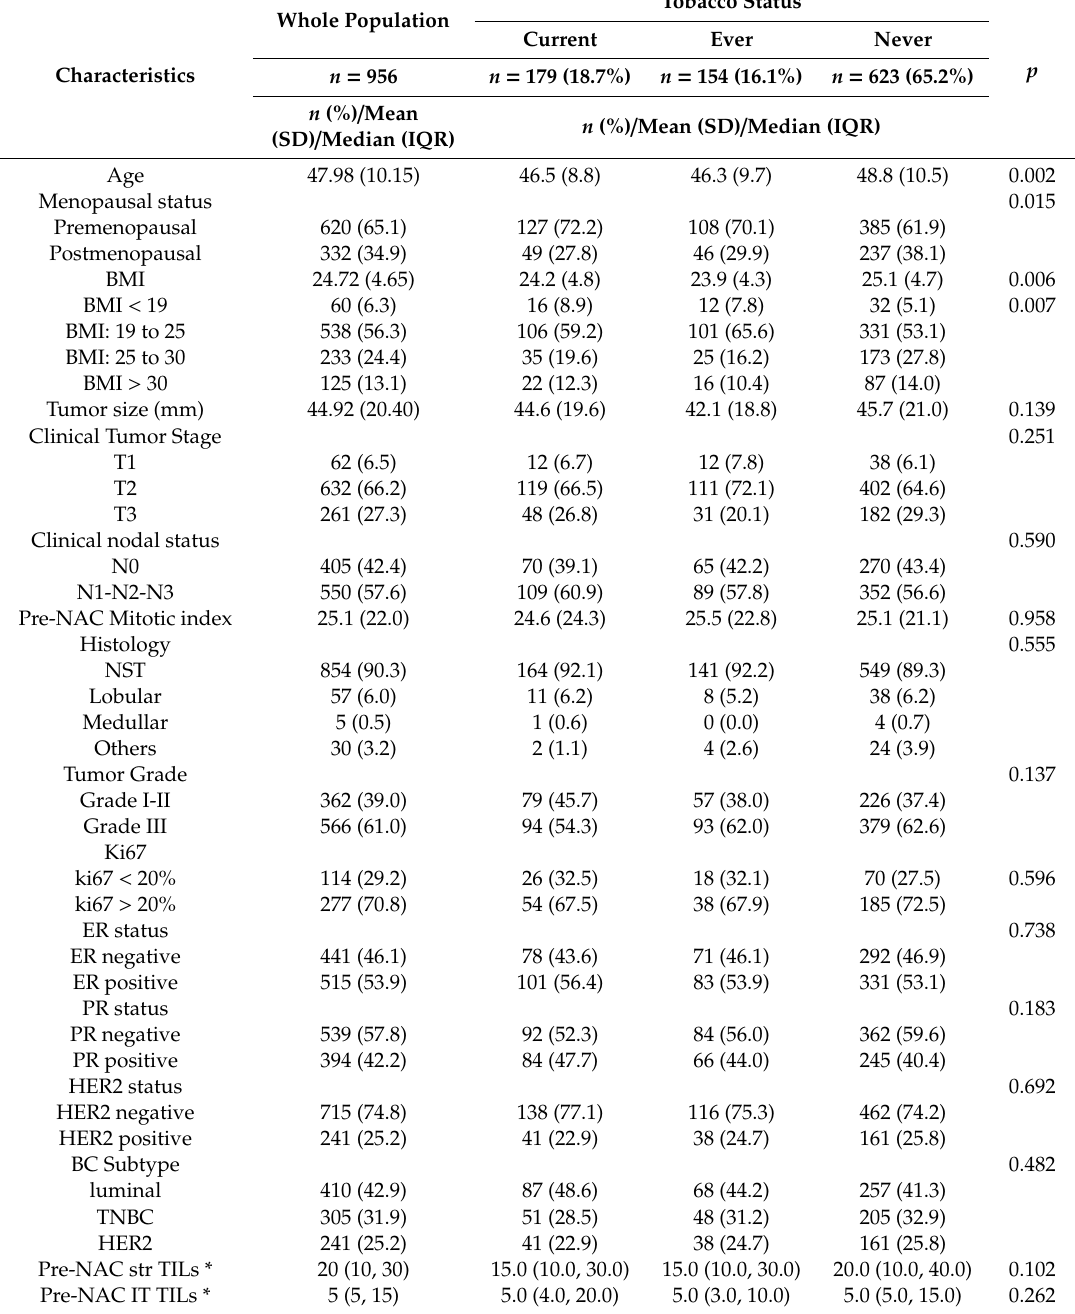
Table 1. Patients’ characteristics among the whole population and according to tobacco status.